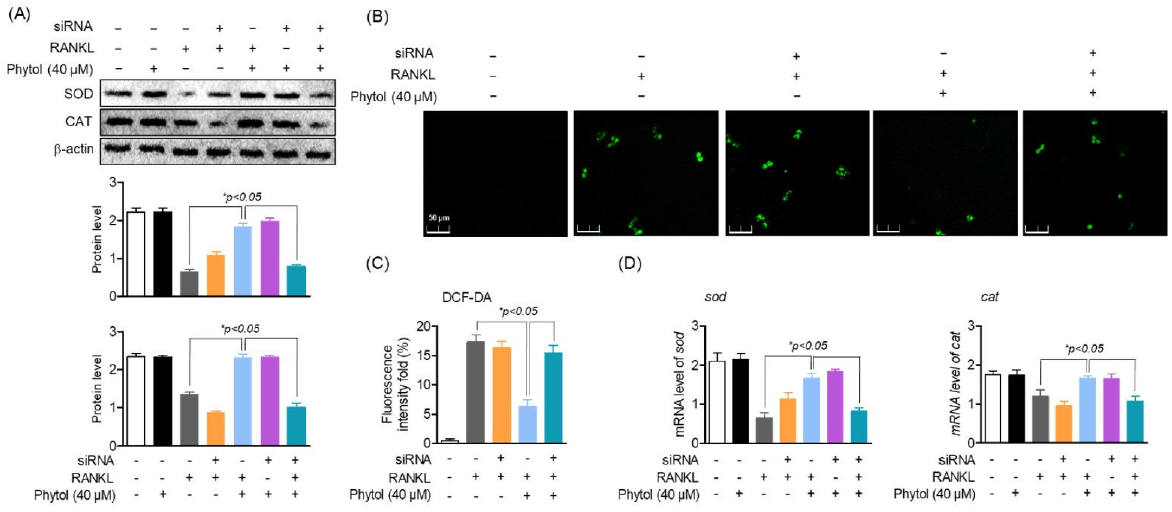
Figure 8. Inhibitory effect of phytol on oxidative stress is regulated through Nrf2. ( A ) In both receptor activator of nuclear factor kappa − B ligand (RANKL)-treated and untreated group, cells were transfected with or without Nrf2 siRNA, in the presence or absence of phytol, and the protein and RNA level of SOD and CAT were investigated using Western blot analysis and RT − PCR, respectively. ( B , C ) ROS production was measured in the presence or absence of 40 µ M phytol, siRNA silencing, and RANKL stimulation to detect the effect of phytol on oxidative stress through Nrf2. ( D ) The mRNA expression of sod and cat were detected by RT-PCR. Data are presented as the mean of three independent experiments (Mean ±